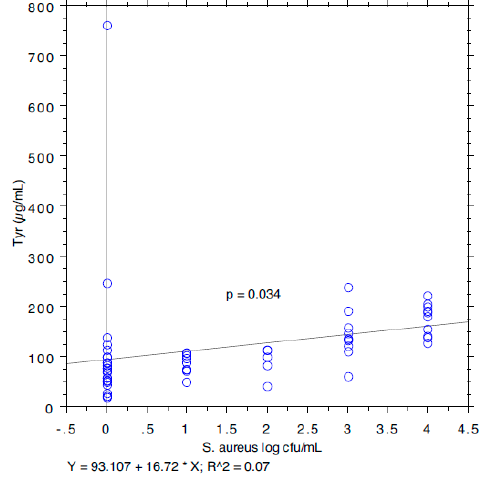
Figure 5. Pearson correlation between tyrosine content and S . aureus load.